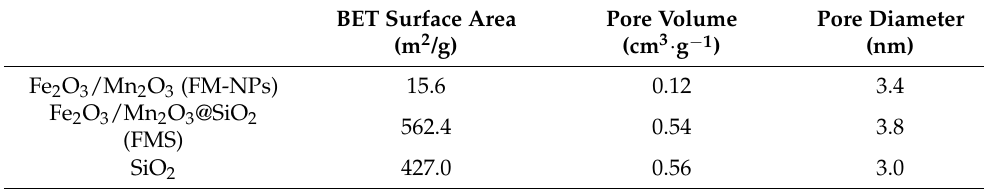
Table 1. Surface area and porosity properties of synthesized materials.